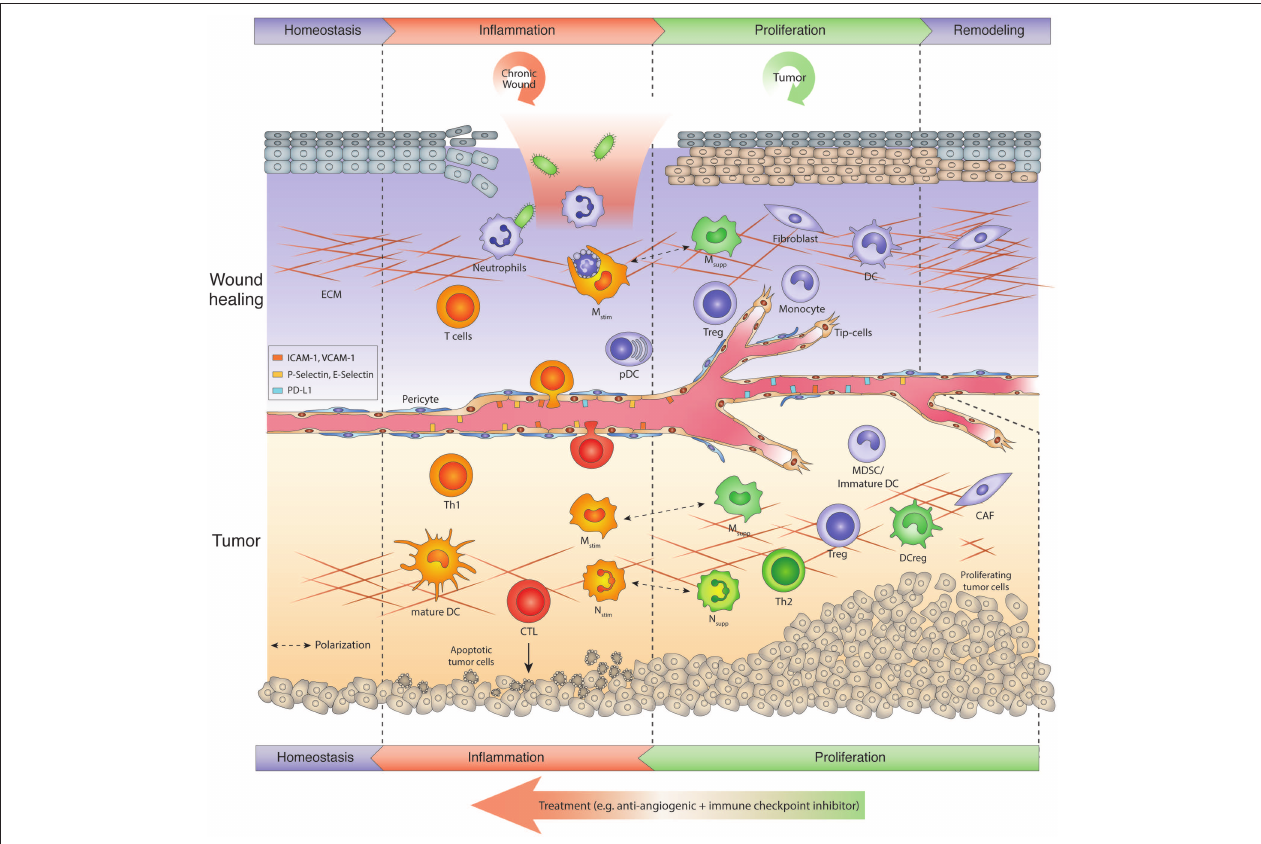
FIGURE 1 | Tumors hijack the wound repair program: Chronic wound vs. tumor wound. Usually wound healing is manifested in several sequential steps after injury referred to as inflammation, proliferation-resolution, and remodeling phase. Immune cells are key regulators in the wound repair program. In the inflammation phase, neutrophils kill microbes and macrophages phagocytose apoptosing neutrophils, while skin-resident or infiltrating T cells produce IL-17, IL-22, and TNF α to amplify the host defense response. During the proliferation phase, macrophages switch to an anti-inflammatory phenotype (M supp ). M supp macrophages, N supp neutrophils (or tumor-associated neutrophil, TANs), Tregs and other immunosuppressive cells may help to attenuate the inflammation response and facilitate resolution and tissue remodeling. Chronic wounds get trapped in the inflammation phase, exacerbate inflammation and thus, hinder tissue repair. Tumors, on the other hand, hijack the proliferative/remodeling program and provide signals that create a continuous angiogenic and immunosuppressive environment enabling tumors to grow and escape immune surveillance. Therefore, tumors remain in the proliferative phase upon the onset of angiogenesis. Antiangiogenic immunotherapies induce an inflammation